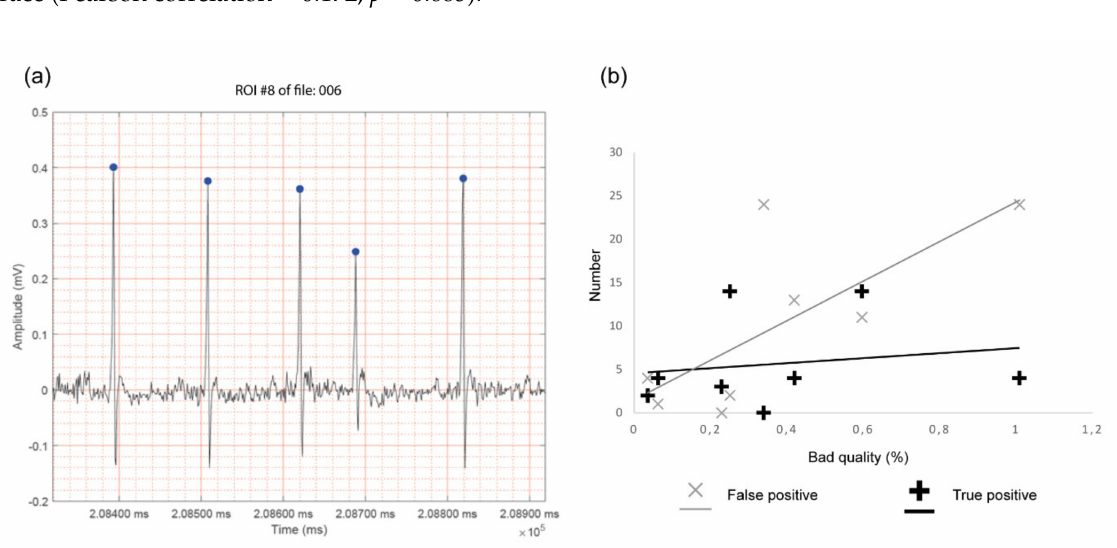
Figure 6. Ectopic beat detection. ( a ) Representative output obtained for ectopic beat detection showing the aberrant RR-interval. Detected R-peaks are indicated with blue dots on the band-pass filtered ECG-trace. ( b ) Correlation analysis between the percentage of bad quality of the ECG trace and false positive and true positive ectopic beat detection ( n = 8 ECG traces of twenty minutes). The number of false positive and true positive ectopic beats are depicted with a grey x and a black + , respectively. ROI; Region of